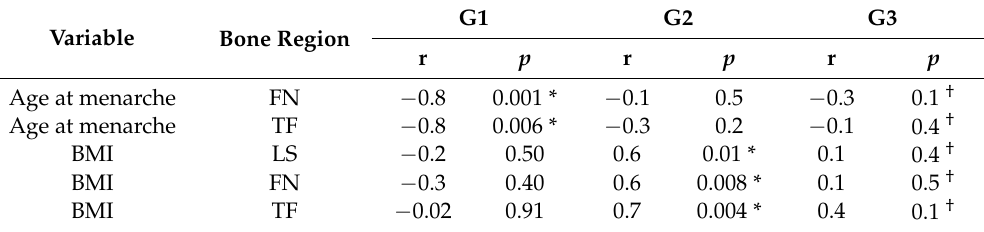
Table 3. Correlation between age at menarche and BMI with LS, TF, and FN BMD. Variable